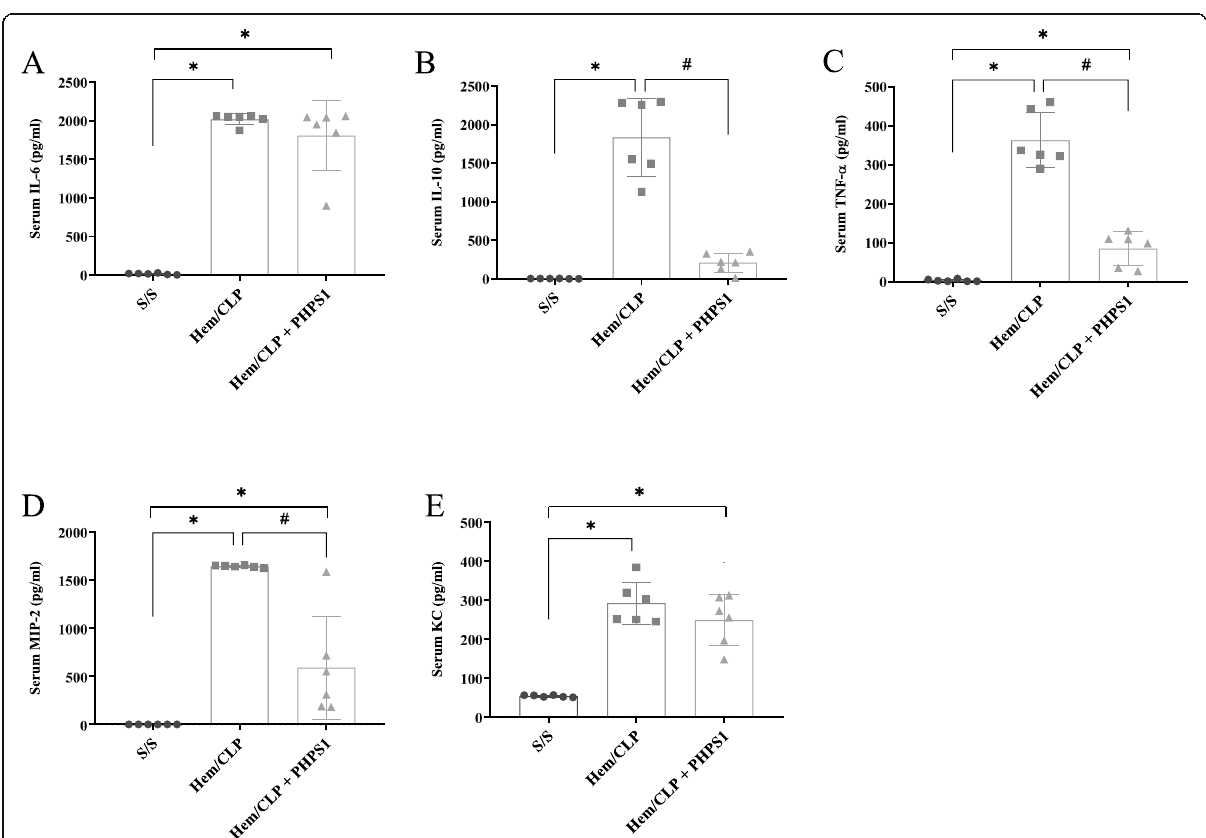
Fig. 5 Effects of PHPS1 on systemic plasma levels of inflammatory cytokine/chemokine produced after Hem/CLP. The plasma levels of IL-6 ( a ), IL- 10 ( b ), TNF- α ( c ), MIP-2 ( d ) and KC ( e ) in the vehicle or the PHPS1 treated Hem/CLP mice were increased compared to the Sham animals. However, this Hem/CLP-induced increase was markedly suppressed by PHPS1 treatment for IL-10, TNF- α and MIP-2, but not IL-6 and KC levels. * P < 0.05, versus Sham (S/S); # P < 0.05, PHPS1 treated group (Hem/CLP + PHPS1) versus Hem/CLP+ vehicle (Hem/CLP) . One-way ANOVA and a Student-Newman-Keuls ’ test, Mean ± SD; n = 6